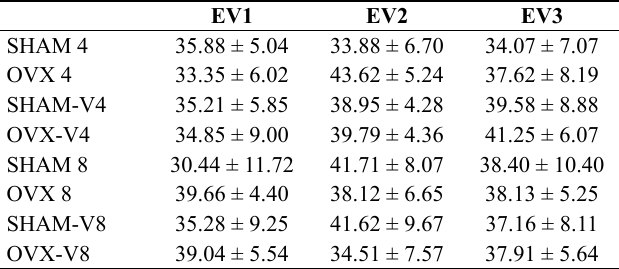
Table 1. Nociceptive threshold of the right hind paw of Wistar rats